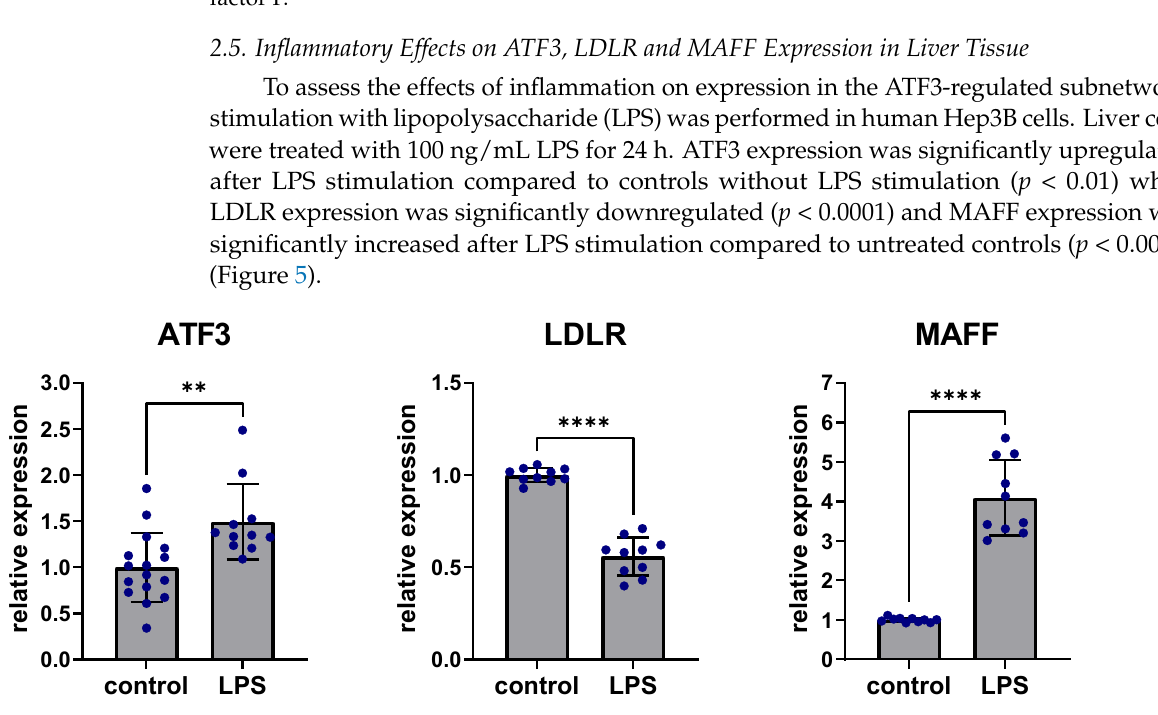
pository of its kind. Transcriptomic data are available for blood, internal mammary artery, atherosclerotic aortic root, subcutaneous fat, visceral abdominal fat, skeletal muscle and